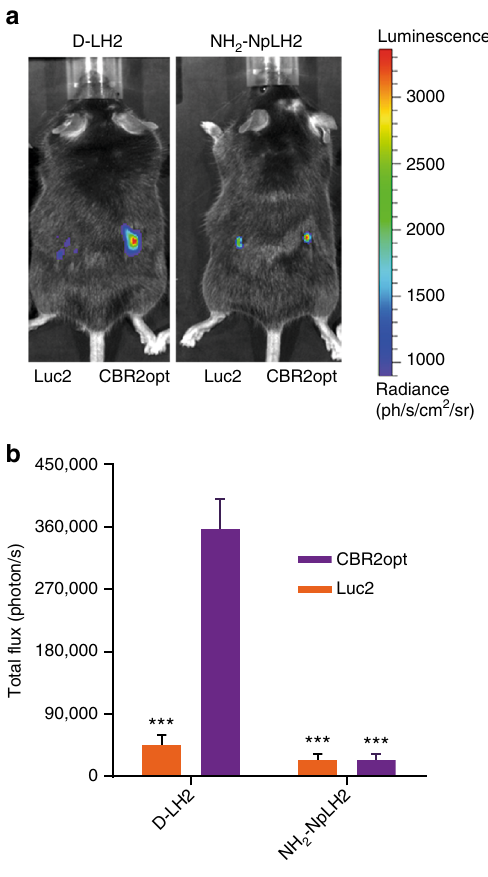
Fig. 3 Imaging the backs of C57BL/6 black fur mice. a Representative bioluminescence images of mice after subcutaneous implantation of 1 × 10 6 of HEK-EF1-Luc2-T2A-copGFP and HEK-EF1-CBR2opt-T2A-copGFP cells and intraperitoneal injection (150 mg kg − 1 ) of either D-LH2 or NH 2 -NpLH2 (data presented as means ( n = 3) ± S.D.). b Quanti fi cation of fl ux (photon/ s) with an exposure time of 60 s (*** p < 0.001 compared to CBR2opt/D- LH2). Error bars represent